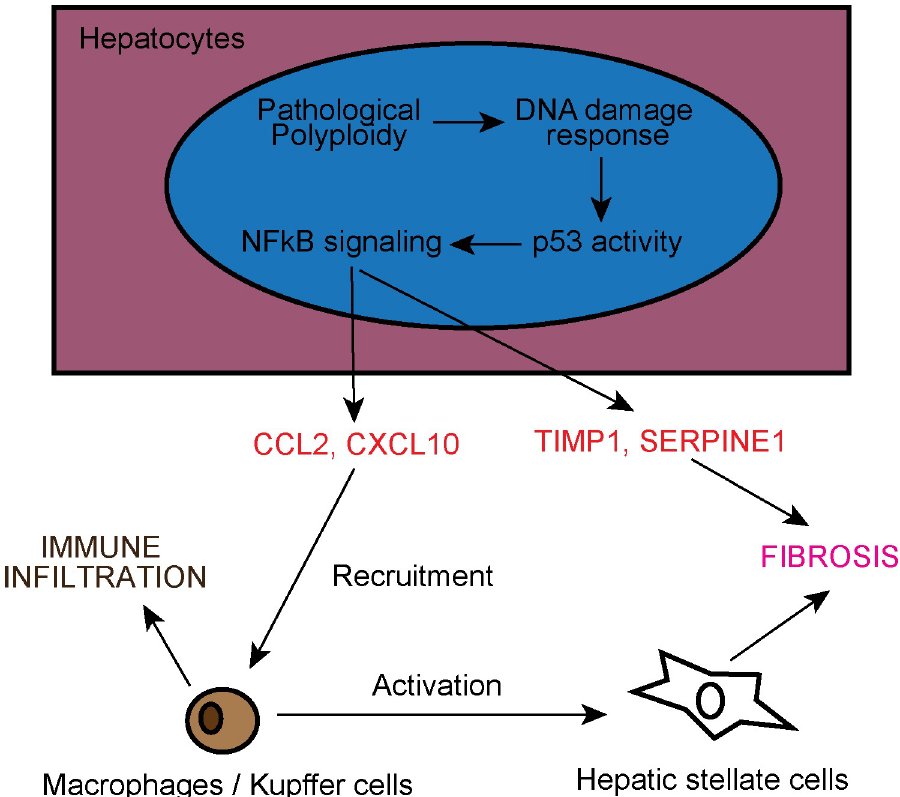
Fig 8. Model of liver inflammation and fibrosis in Cdk1 Liv-/- liver. Pathological polyploidy in Cdk1 Liv-/- hepatocytes activates p53 as part of the DNA damage response, which in turn triggers NF κ B signaling. NF κ B then induces expression of CCL2, and possibly CXCL10, SERPINE1, and TIMP1. CCL2 and CXCL10 recruit monocytes and macrophages leading to immune cell infiltration in the liver. Immune cells subsequently activate hepatic stellate cells to drive liver fibrosis. Separately, SERPINE1 and TIMP1 secreted by hepatocytes also promote the development of fibrosis by blocking the activity of proteases that breakdown extracellular matrix.